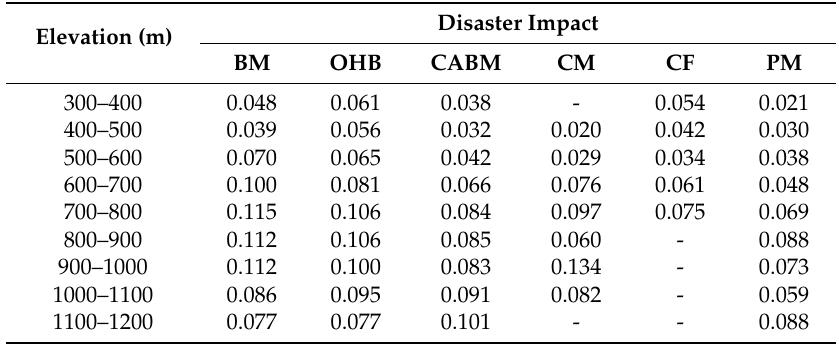
Table 12. Disaster-impact-analysis results for six forest types in di ff erent elevation